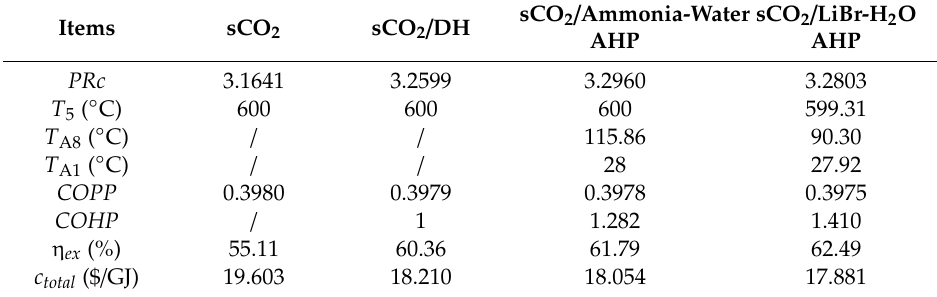
Table 14. Optimized results for the exergy e ffi ciency optimal design case.